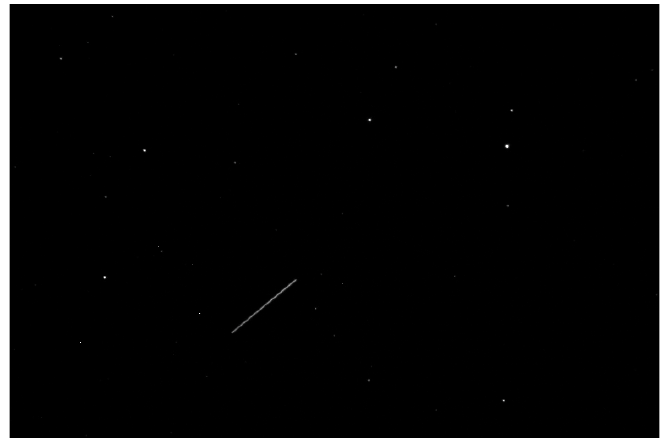
Figure 24. An LEO photographed through the Orion ShortTube 80 telescope.